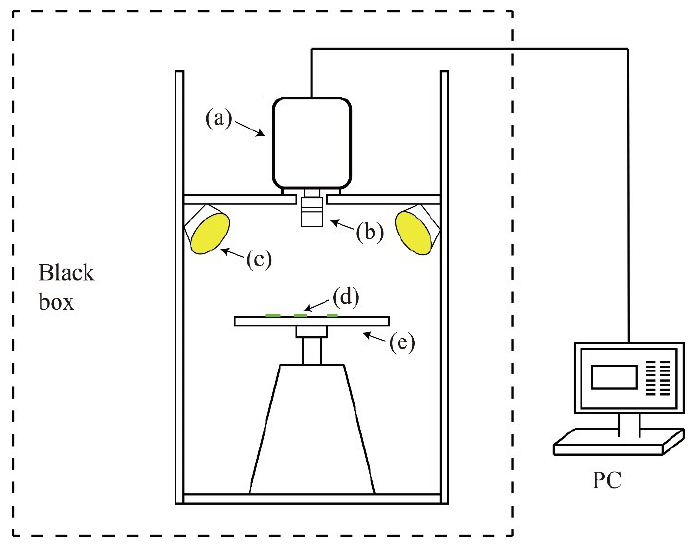
Figure 2. Schematic diagram of the hyperspectral test. ( a ) Spectrometer, ( b ) lens, ( c ) halogen lamp, ( d ) pest sample, and ( e ) objective table.